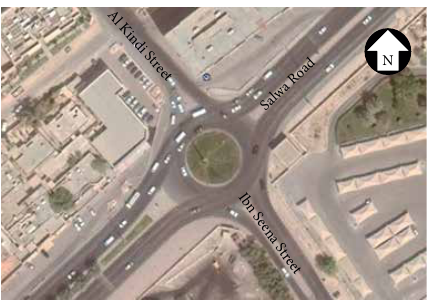
Figure 1: A close-up of the conventional multilane